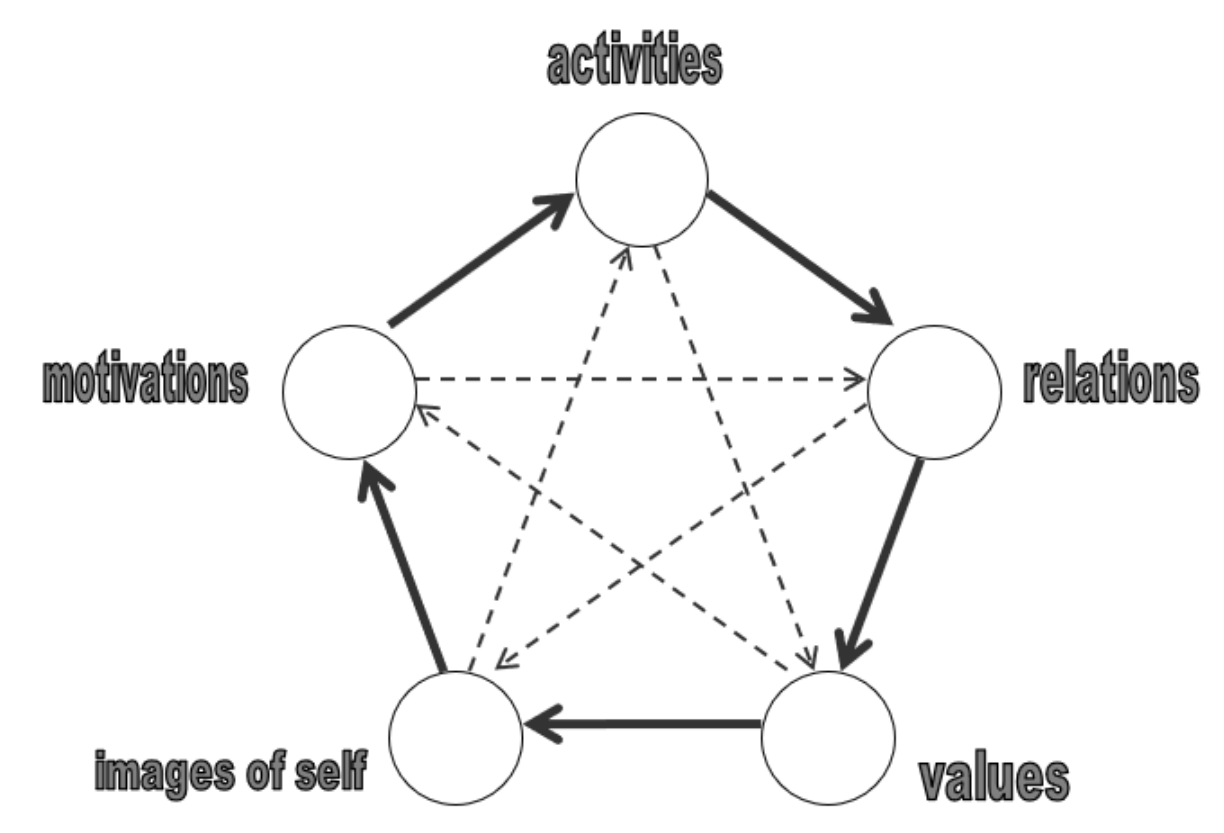
Figure 2. The actor’s system 16 .